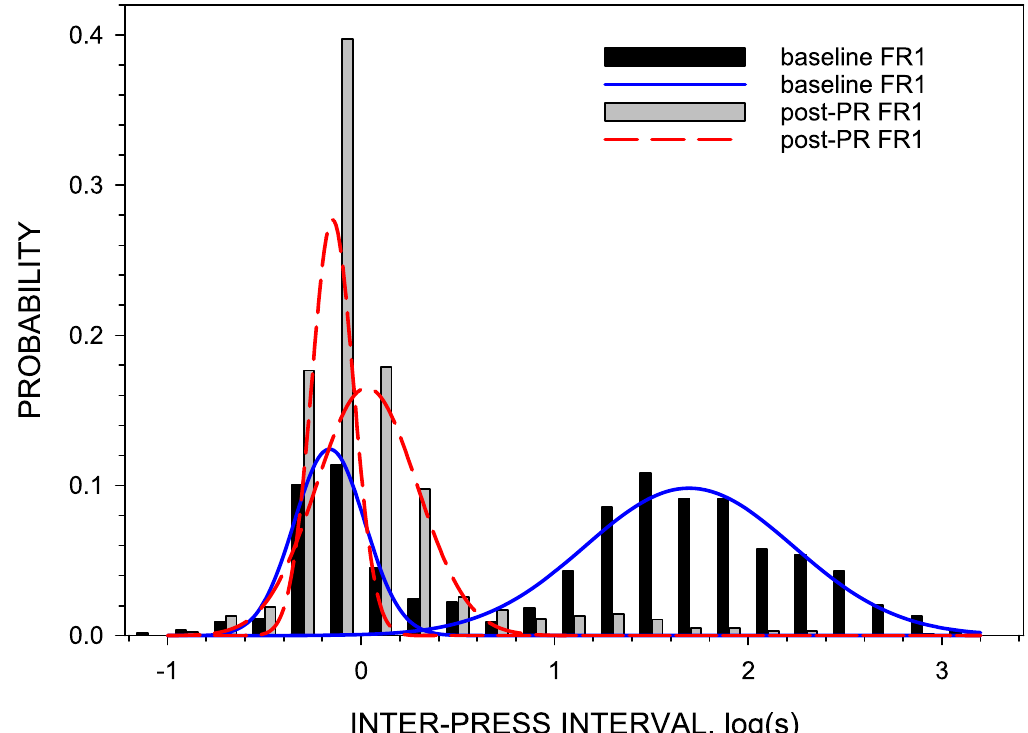
Figure 1. Probability density functions of IPIs during unloading phase in Baseline FR1 and Post-PR FR1 sessions in a representative rat. Both distributions were lognormal and bimodal. Lines represent the best fit of non-linear regression analysis before (solid blue lines) and after (long-dashed red lines) PR sessions. SigmaPlot v. 14.0 (https:// systa tsoft ware.